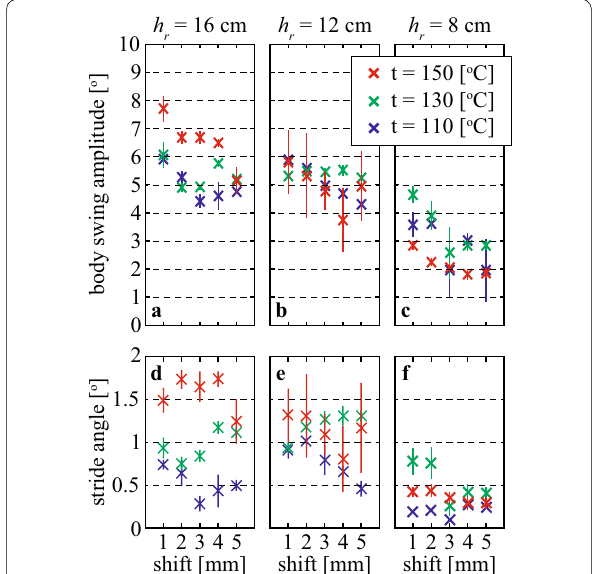
Fig. 16 Body swing amplitude ( a – c ) and stride ( d – f ) against the shift of the weight, with different h